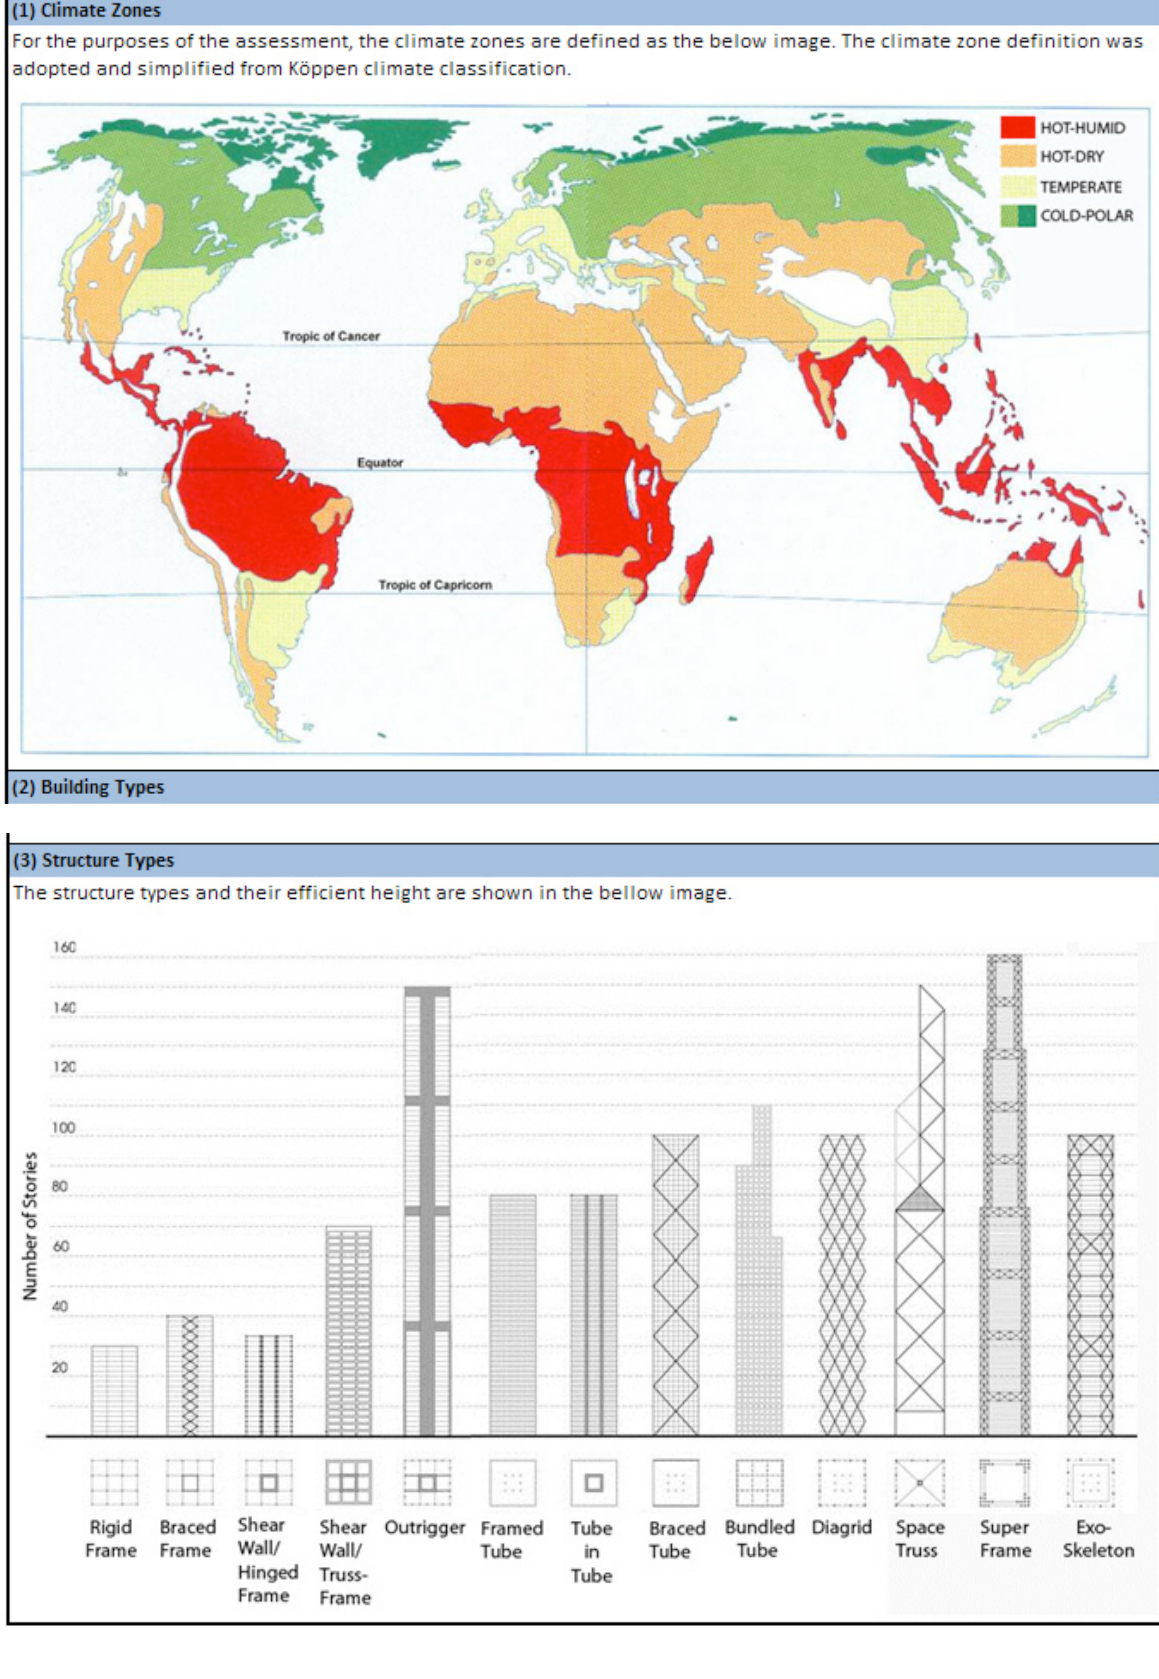
Figure 4. “Project Info”